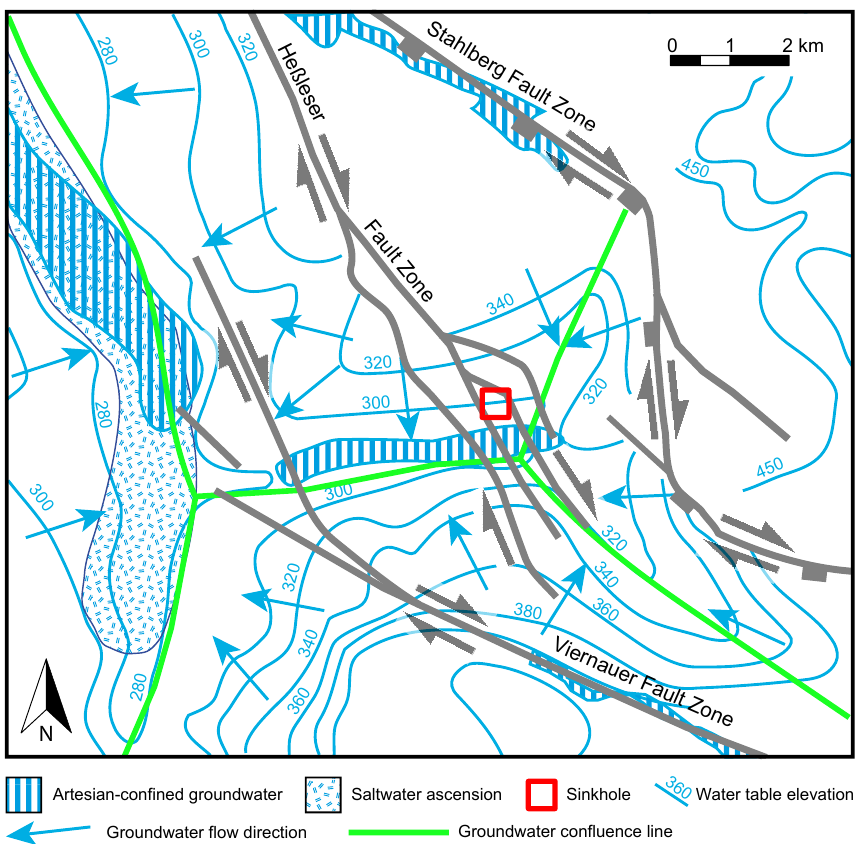
Figure 12. Groundwater table contour map (after TLUG, 2017) reveals a confluence zone of three different groundwater bodies. Three groundwater bodies show different flow routes towards the sinkhole area, and the change in groundwater flow can be seen to correlate with the